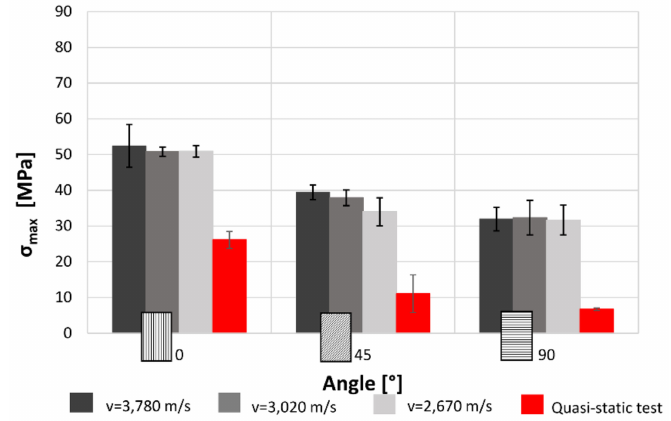
Figure 8. E ff ect on the maximum stress of the raster angles and impact speeds for single-layer